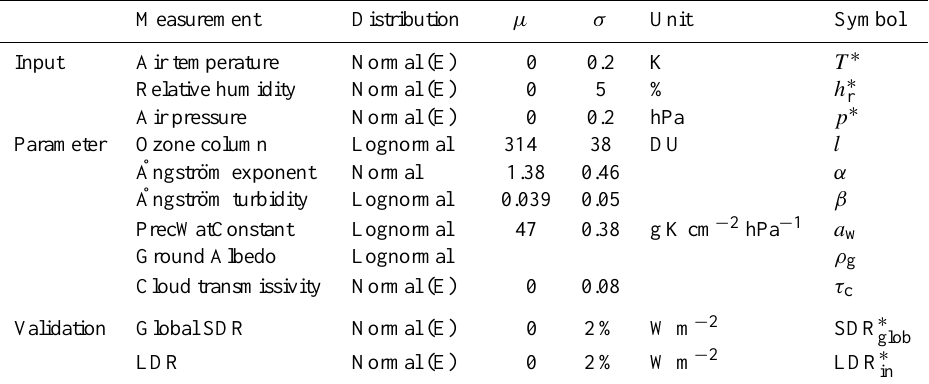
Table 2. Input, model parameters and validation data with uncertainty distributions, mean µ and standard deviation σ . Note that the dis- tribution for the ANETZ and ASRB measurements concern the error of the measurement (denoted with E), whereas the distribution in the parameters concerns the parameter value itself. Since ground albedo varies temporally and spatially, its distribution is estimated for each station and each month separately (Table